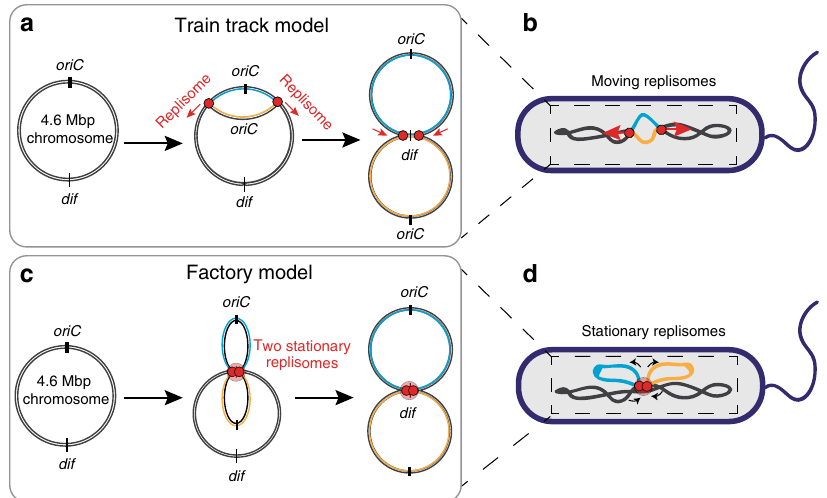
Fig. 1 Schematic depiction of the “ train track ” (top) and factory (bottom) models for E.coli chromosome replication. Train track model ( a , b ): according to the “ train track ” model, replisomes assemble at the origin of replication and then move independently along the chromosome arms (indicated with black arrows), replicating the DNA (replicated DNA depicted in orange and cyan colors). The replisomes then meet at the terminus region and thus fi nish replication. As sketched in b , one should accordingly expect to see two moving replisome foci upon tracking replisome foci in live E.coli cells. Factory model ( c , d ): by contrast, the factory model predicts that the two replisomes stay stationary after assembly at the origin of replication, while the DNA is being pulled through them (black arrows). As a consequence, replicated DNA (depicted in orange and cyan) is segregated by being pushed towards the cell poles. As sketched in d , labelled replisomes are thus predicted to form a single and stationary replication focus inside the